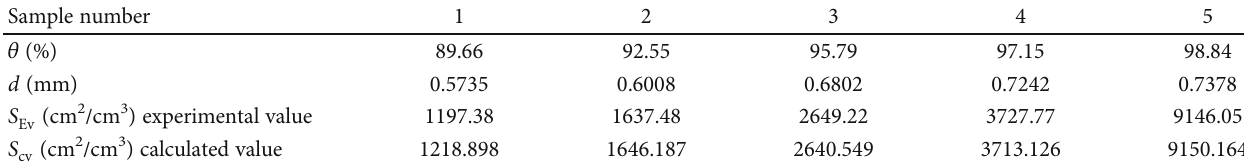
Table 3: Experimental data and theoretical calculation data of foamed